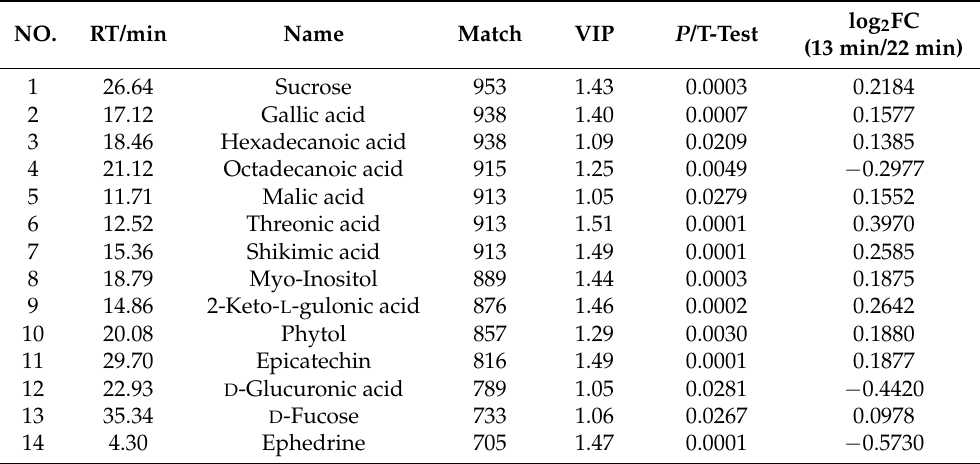
Figure 3. ( A ) Heat map of metabolites in YAYT treated with 13 min and 22 min roasting, respectively. Group A, YAYT roasted for 13 min; Group B, YAYT roasted for 22 min. Warm color and cold color indicated increased and decreased expression of the metabolites, respectively. ( B ) Loading plot of metabolites in YAYT treated with 13 min and 22 min roasting, respectively. Group A, YAYT roasted for 13 min; Group B, YAYT roasted for 22 min. Spots in pink indicate samples from group A, and spots in green show samples from group B, based on the criteria of VIP > 1, p < 0.05, and match score ≥ 700. Table 4. The differential metabolites of YAYT with different roasting